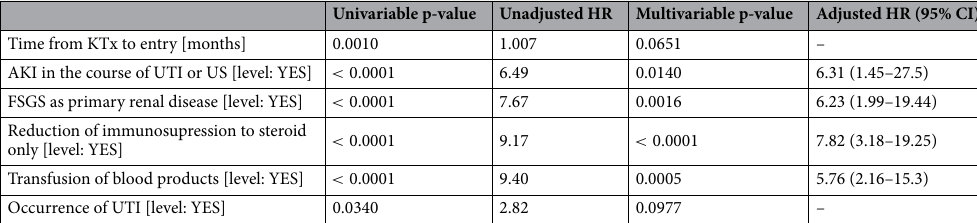
Table 6. Multivariable Proportionate Cox Hazard model for predictors of death-censored graft loss at 1 year. Adjusted for time from transplantation and occurence of UTI. Adjusted R2 = 0.8925; 95% CI 0.8706–0.9164; p < 0.0001